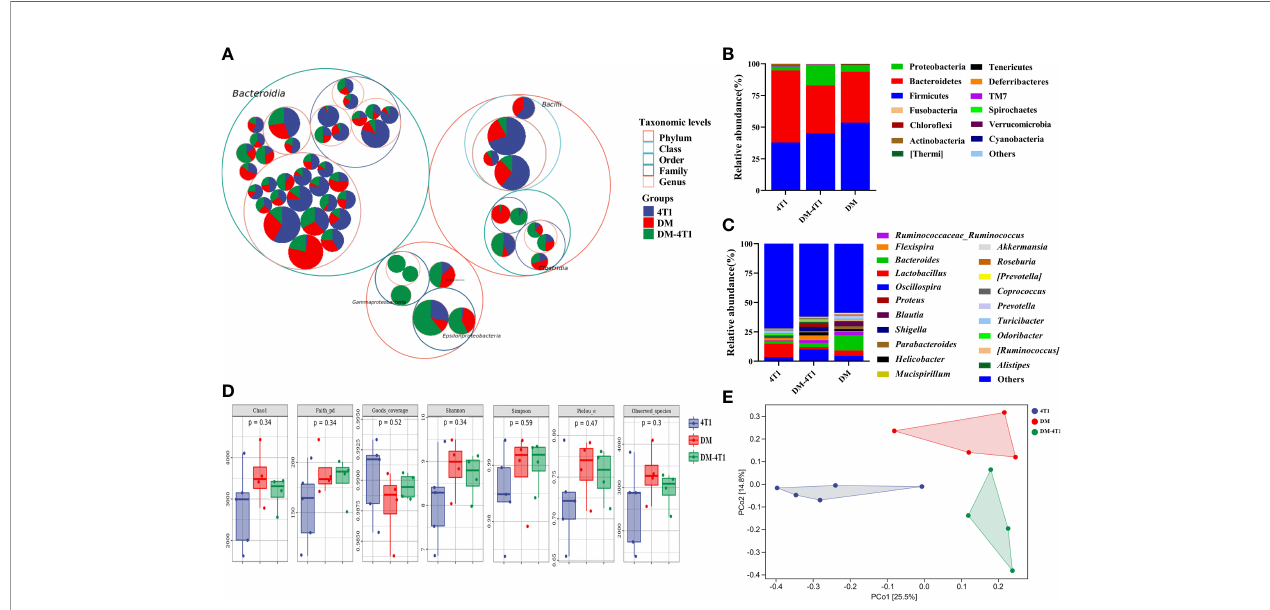
FIGURE 2 | DM changed gut microbiome diversity. (A) Taxonomic differences are based on 16S rRNA sequencing. Taxonomic composition was visualized by circular packing. The largest circles represent phylum level, and the inner circles represent class, family, and genus, respectively. The circle sizes represent the mean relative abundance of the taxa. The taxa were colored by sample groups (red for DM-4T1 and blue for 4T1), whereas the area of the group corresponded to the mean relative abundance of the taxa in each group. (B, C) Total gut bacterial relative abundance at the taxonomic rank of phylum (B) and genus (C) of 4T1 and DM- 4T1 groups. (D) Alpha diversity boxplot (Chao1, Faith pd, Goods coverage, Simpson, Pielou, and Observed_species) in 4T1 and DM-4T1 groups. (E) PCoA of microbial communities of 4T1 and DM-4T1. PCoA was calculated using the Bray – Curtis similarity